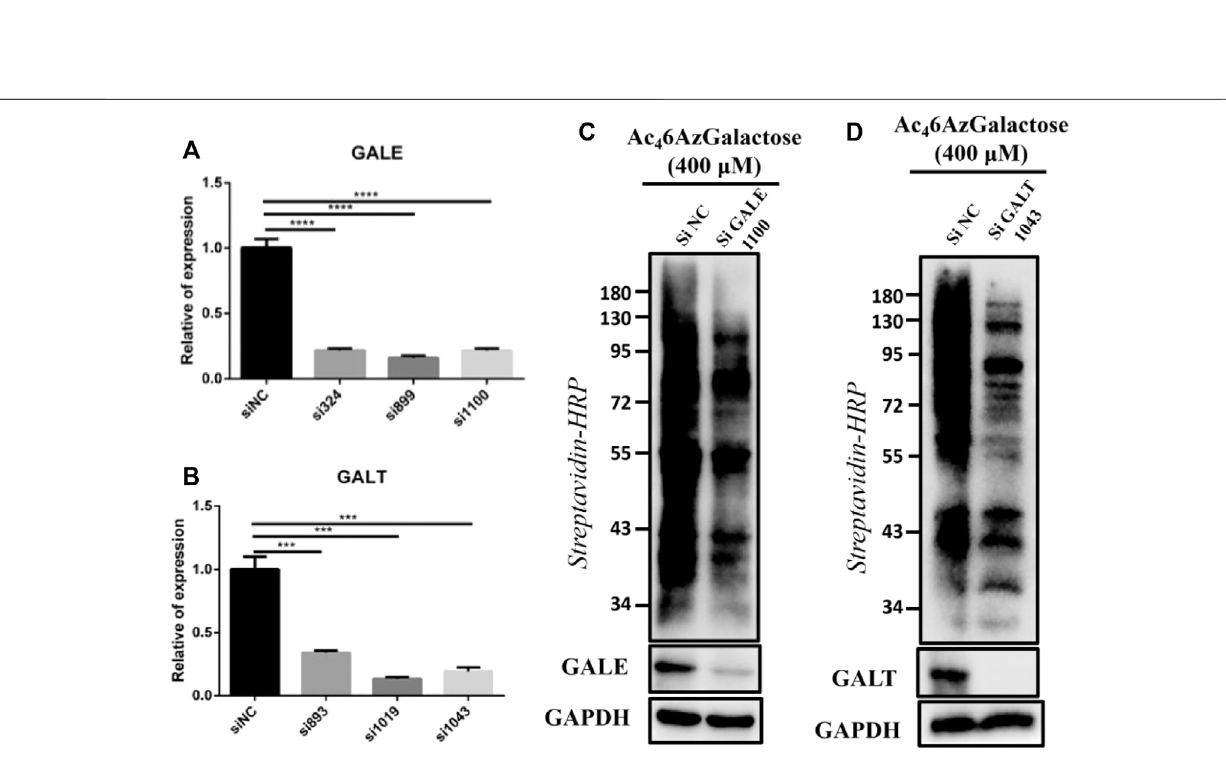
FIGURE8| CharacterizingtherolesofGALTandGALEinthelabelingofAc The in fl uences on Ac 4 6AzGal labeling after inferring the expression of GALE (C) and GALT (D) .